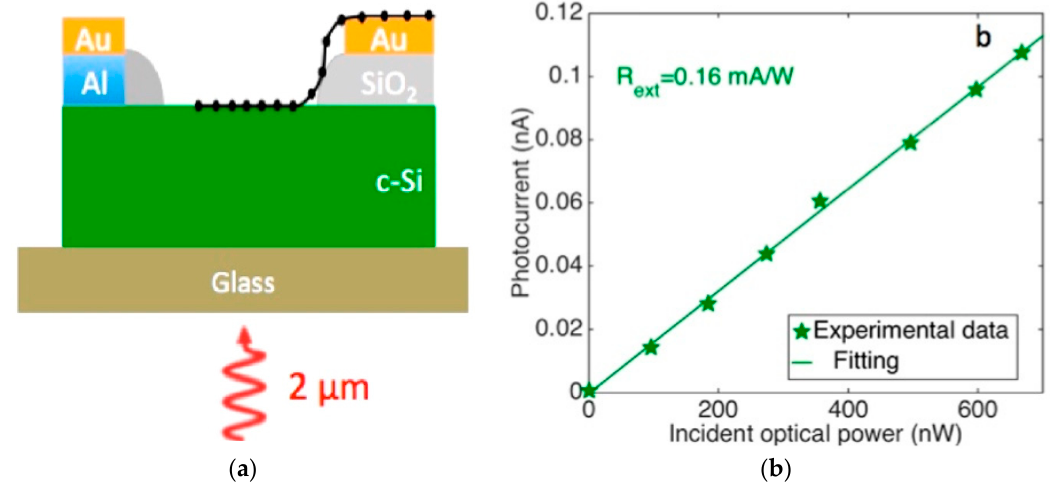
Figure 8. ( a ) Schematic cross-sectional view of the graphene / Si Schottky PD investigated in Casalino [28], ( b ) Measured current vs incident optical radiation. Reprinted with permission from (Casalino, Russo, Russo, Ciajolo, Di Gennaro, Iodice, Coppola. Free-Space Schottky Graphene/Silicon Photodetectors operating at 2 μ m. ACS Photonics 2018 , 5 , 4577–4585. Copyright (2018) American Chemical Society. Table 1. Summary of selected near-infrared silicon Schottky photodetectors based on graphene. Ref.